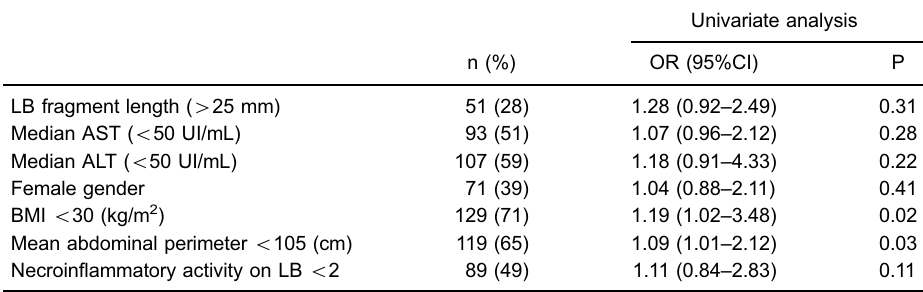
Table 4. Factors associated with diagnostic accuracy of transient elastography.